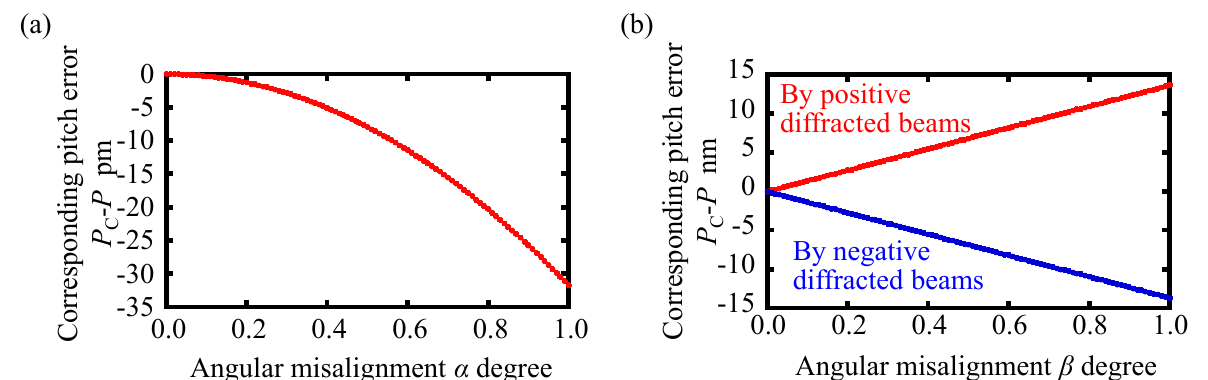
Figure 4. Influence of misalignments in the setup; ( a ) Influence of the angular misalignment of the measurement laser beam about the Z -axis ( α ); ( b ) Influence of the angular misalignment of the measurement laser beam about the X -axis ( β ).